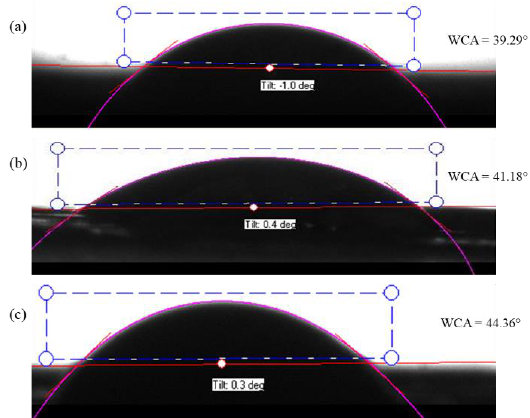
Figure 6. Water contact angle of the hydrogel; ( a ) PAN/AM/CaCl 2 ( b ) PAN/AM/graphene/CaCl 2 and ( c ) PAN/AM/ MWCNTs /CaCl 2 . and ( c ) PAN/AM/MWCNTs/CaCl 2